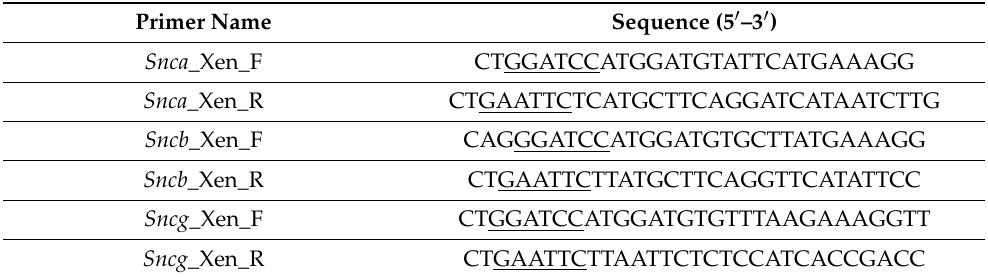
Table 3. Oligonucleotide sequences used for cloning of syn coding sequences. Restriction sites used for cloning in pGEX-2T are